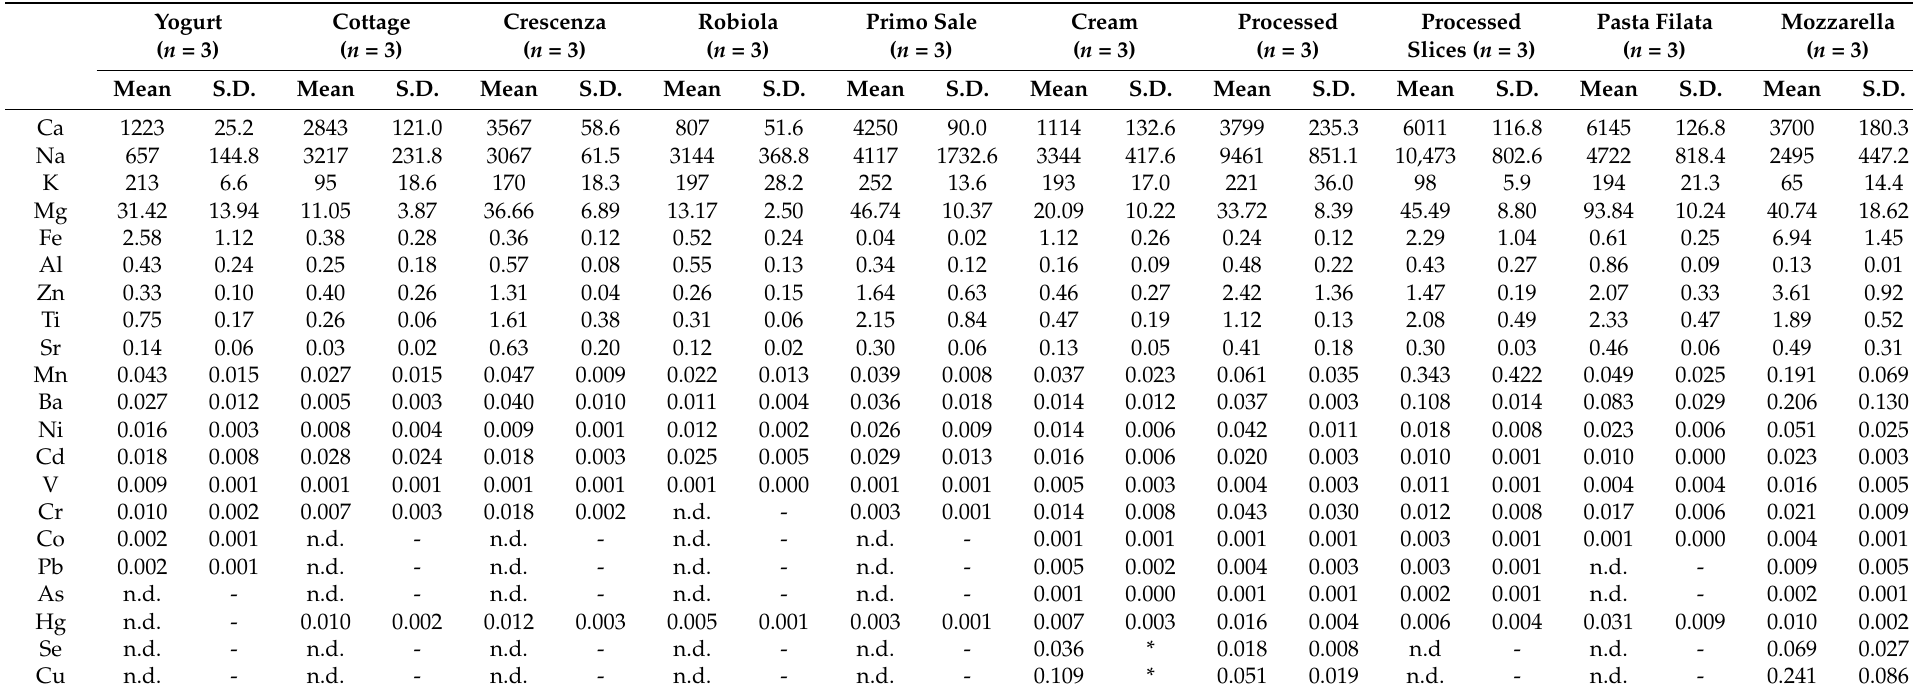
Table 4. Element contents (mg/kg) in 10 different varieties of Italian dairy products (mean ± standard